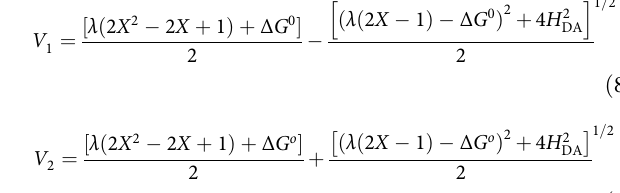
Table 1. Compared to the bridged d 5-6 metal dimers, the H ab parameters for the Mo 2 MV systems are generally small. The